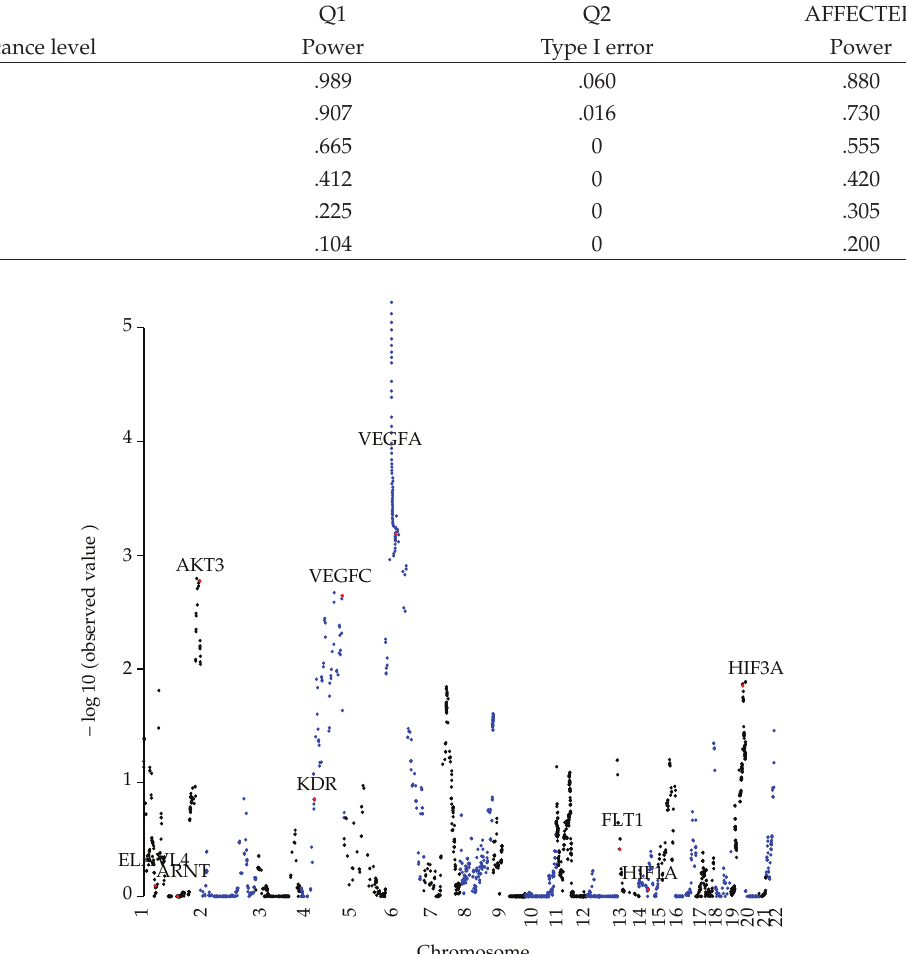
Figure 1: Manhattan plot of Q1 and IBD information where the true loci are